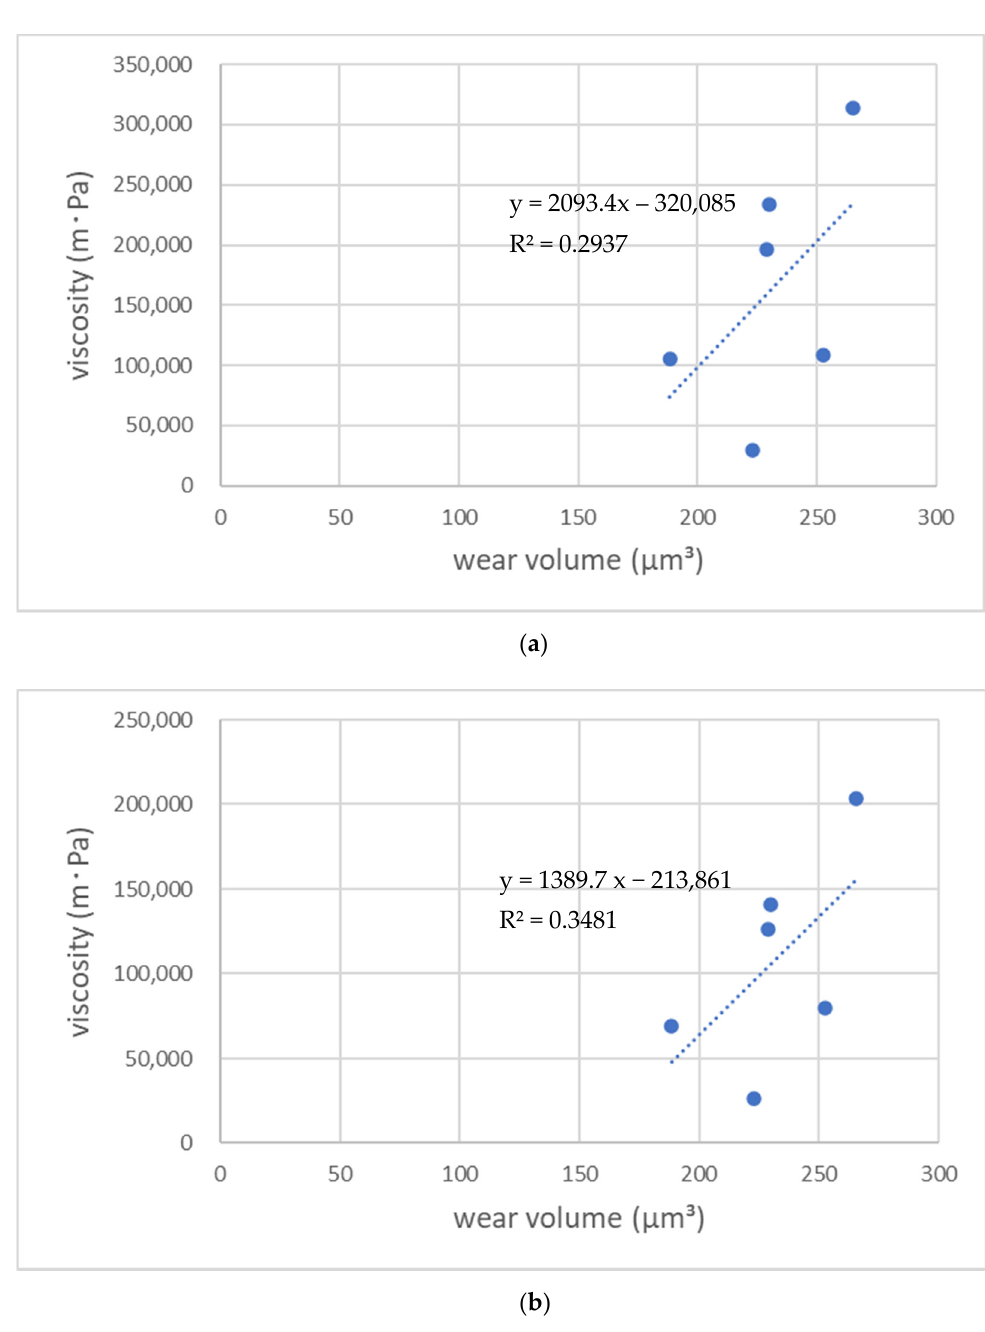
Figure 6. Correlation between the viscosity and wear volume values of the flowable resin composites at shear rates of 1.0 s − 1 ( a ) and 2.0 s − 1 ( b ). A weak positive correlation was observed at the shear rate of 2.0 s − 1 (R 2 = 0.3481), whereas no correlation was observed at the shear rate of 1.0 s − 1 (R 2 = 0.1815).